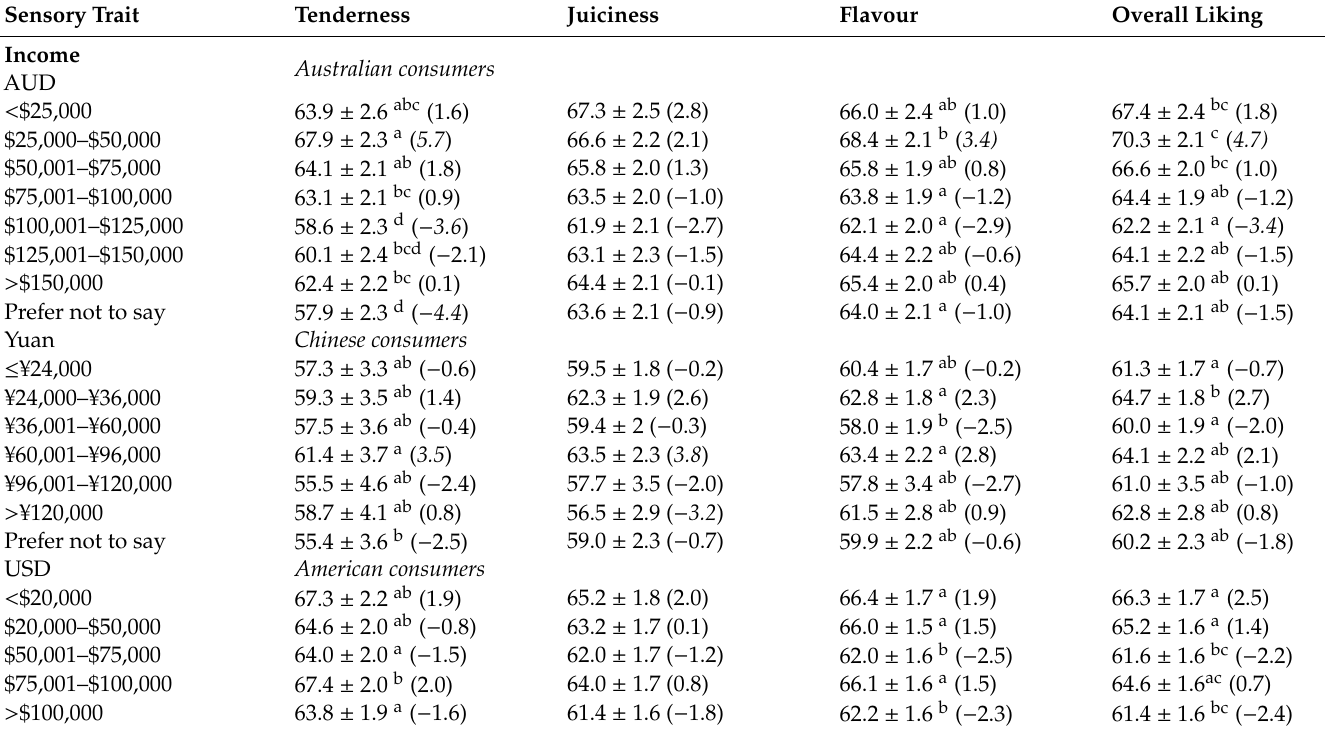
Table 4. Least square means ± standard error (on a scale of 0–100) of tenderness, juiciness, flavour and overall liking scores of sheepmeat samples by a consumer’s income bracket. Values within brackets signify di ff erence from mean of country ( italics = greater than 3 units from the mean